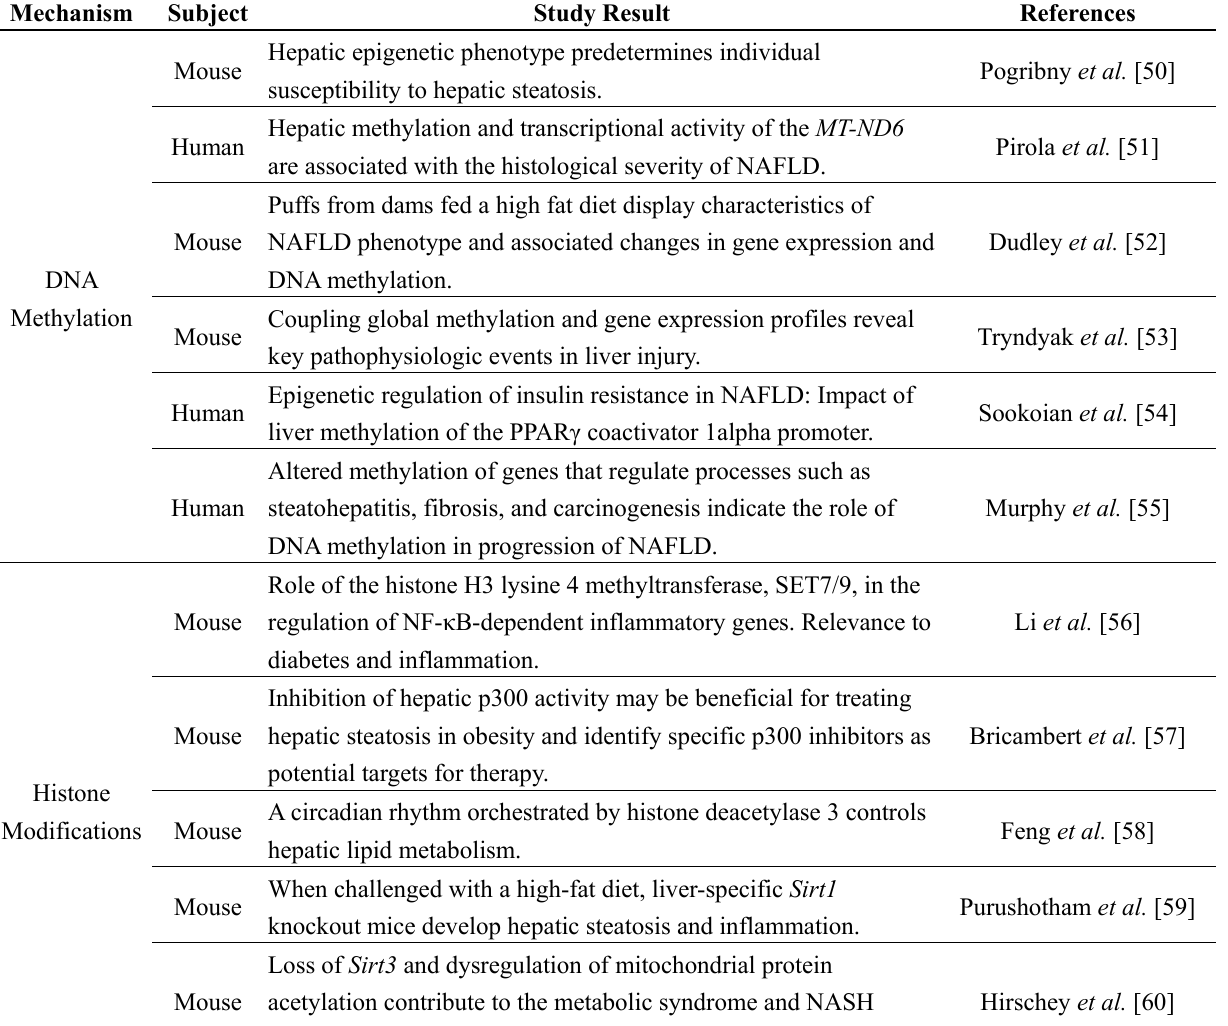
Table 1. Epigenetic mechanism for non-alcoholic fatty liver